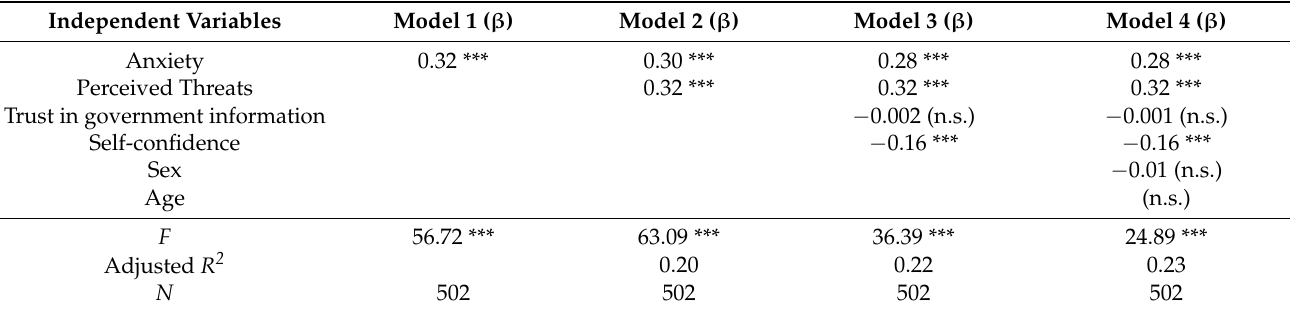
Table 5. Regressions